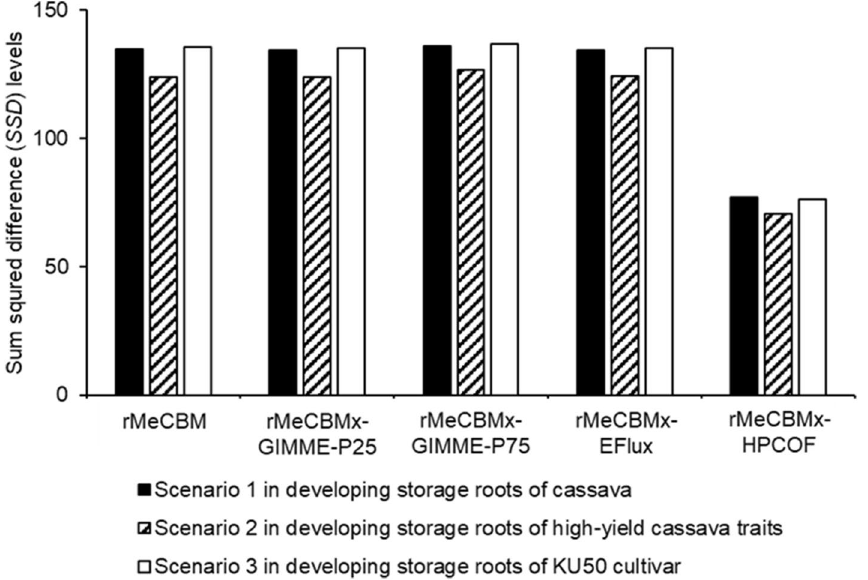
Figure 5. The sum of squared difference ( SSD ) between ranked predicted fluxes from each algorithm and ranked gene expression levels in specific conditions of cassava storage roots. The lower SSD indicates the higher consistency between flux prediction and gene expression